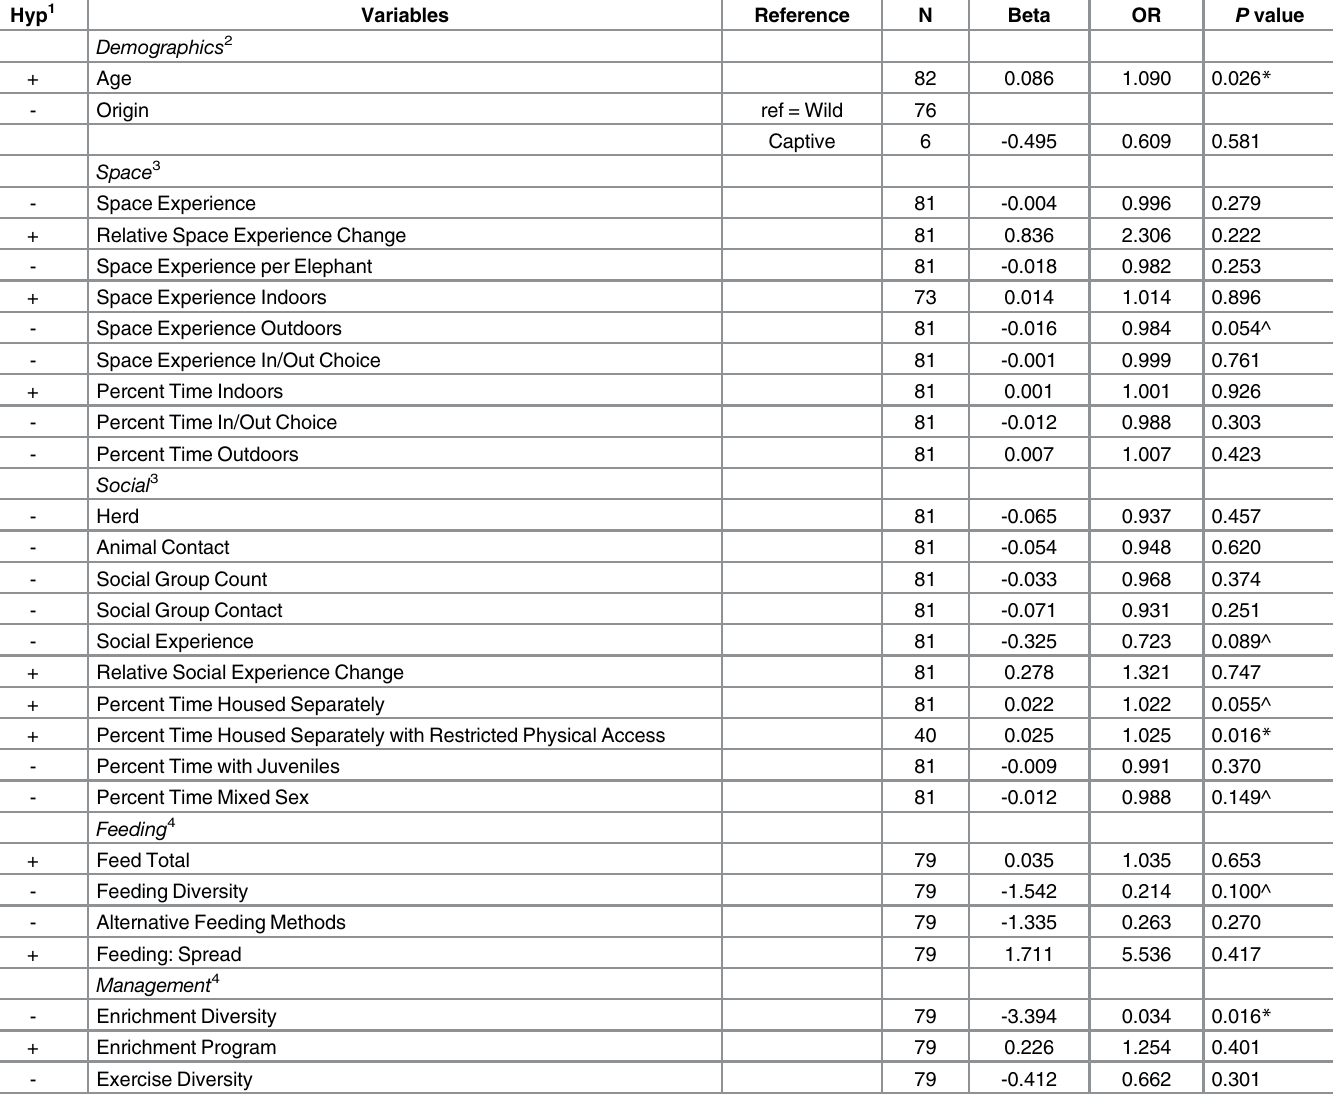
Table 6. Univariate assessment of ovarian acyclicity using logistic regression. OR: Odds